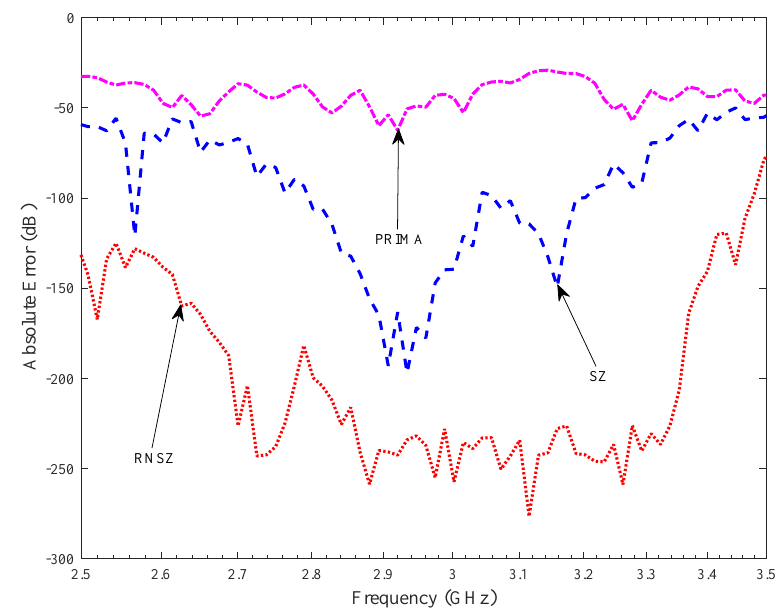
Figure 10. The absolute error plot shows minimum error for the RNSZ method. The calculated mean absolute error for the interconnect bus example in the frequency of interest is − 180.52 dB, − 112.93 dB and − 42.61 dB for RNSZ, interpolation by SZ and PRIMA methods